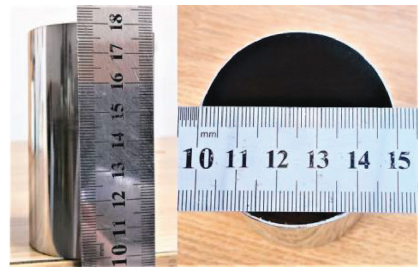
Figure 1: Thin-walled empty pipe.